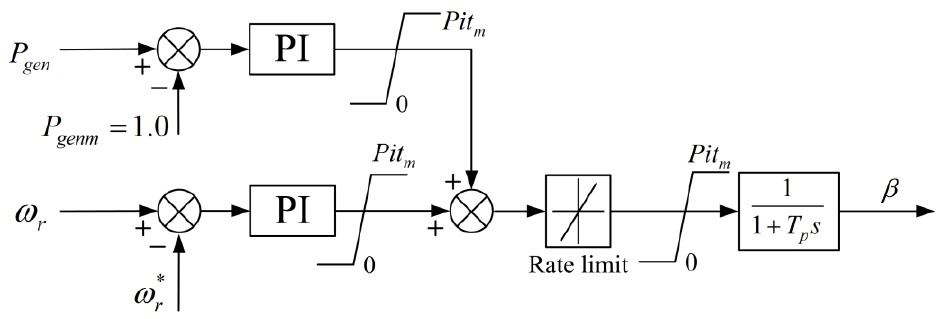
Figure 4. Control strategy of the turbine pitch angle.